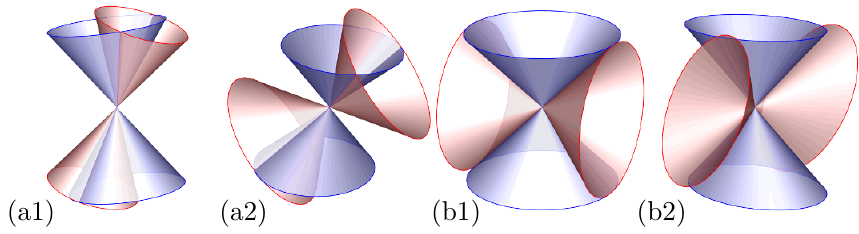
Figure 2 . (a) Causally coupled, and (b) Null coupled cones.